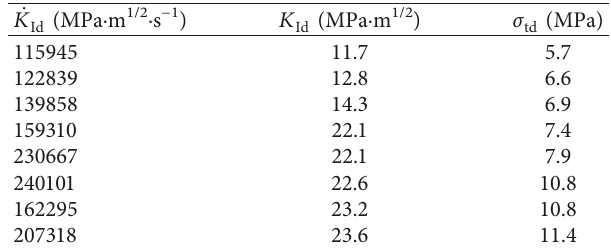
Table 5: Dynamic fracture toughness and dynamic tensile